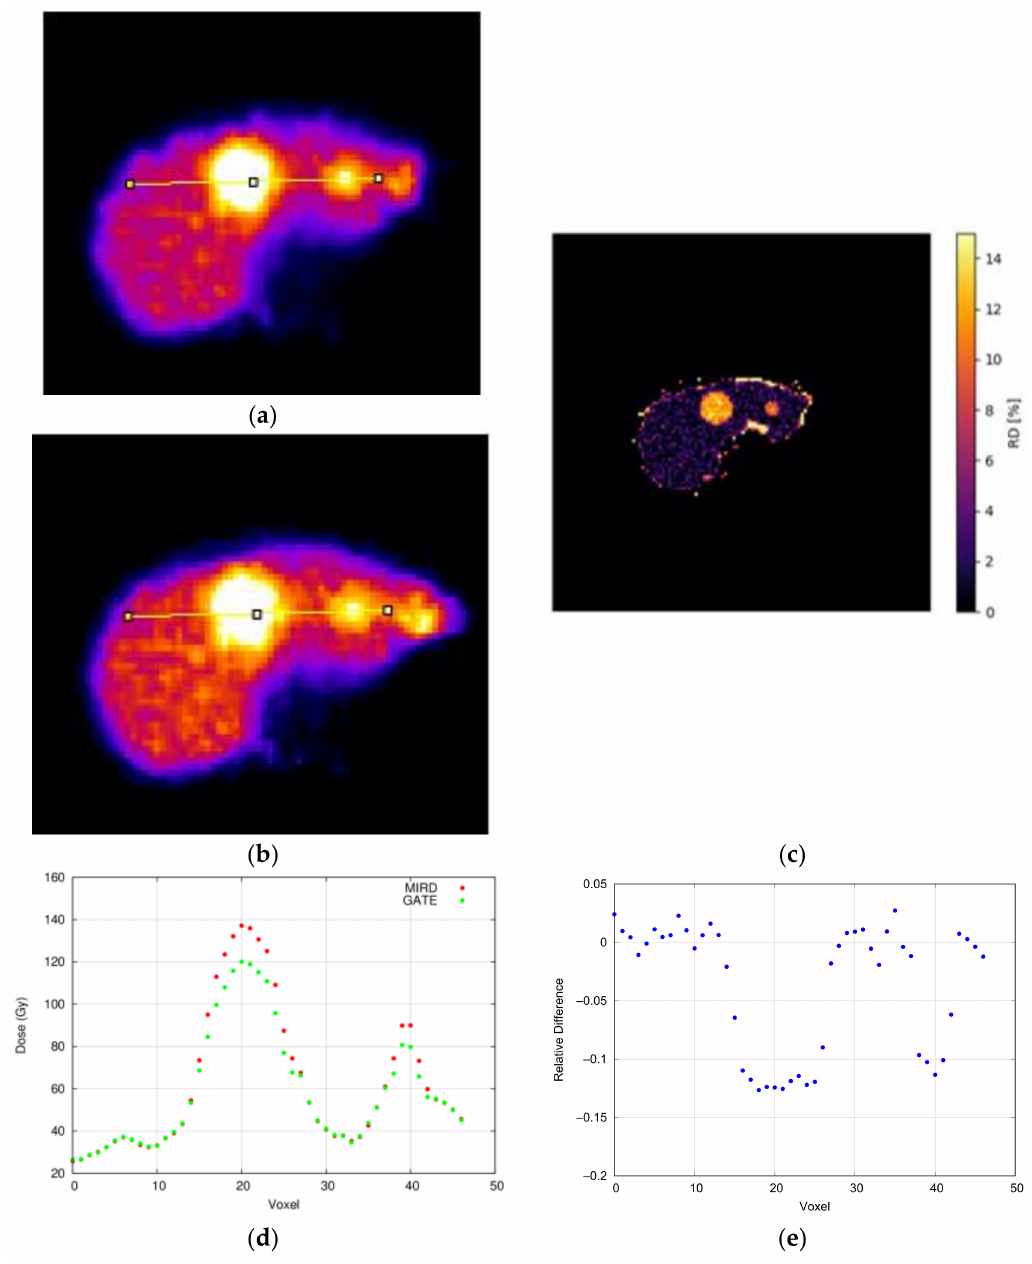
Figure 7. Absorbed dose profile for the NUL-b case and comparison. ( a ) Absorbed dose image obtained with the MIRD schema and absorbed dose profile selection; ( b ) absorbed dose image obtained with GATE and absorbed dose profile selection; ( c ) relative difference (RD) image for the whole slice; ( d ) comparison between absorbed dose profiles; ( e ) plot of the absorbed dose relative differences RD for each voxel of the